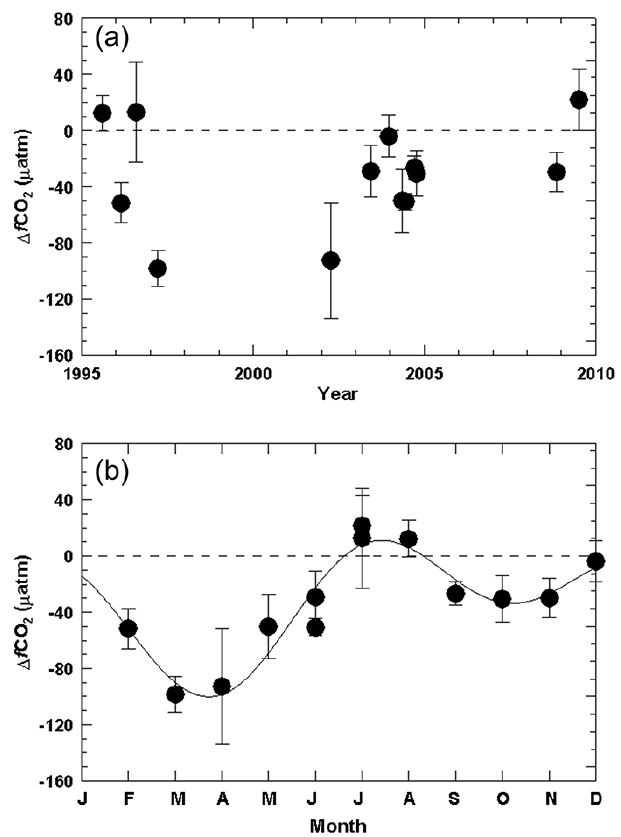
Fig. 4. (a) The secular variations in 1f CO 2 and (b) monthly vari- ation of 1f CO 2 in the Ulleung Basin, East/Japan Sea, from 1995 to 2009. Error bars represent one standard deviation from the mean value.